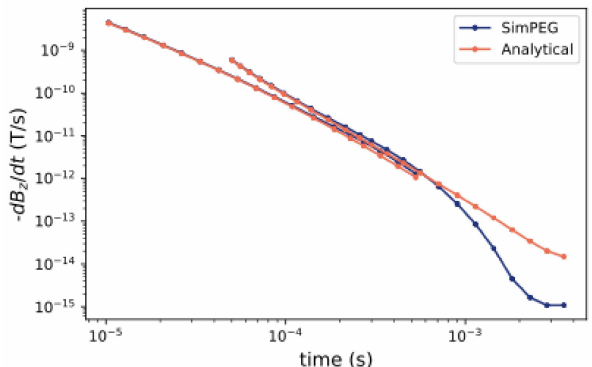
Figure A1. When comparing the generated data via simulation software with an exact forward model, one can get an indication of how to improve the mesh. In this case, where the late time channels break down, the mesh size should be increased.